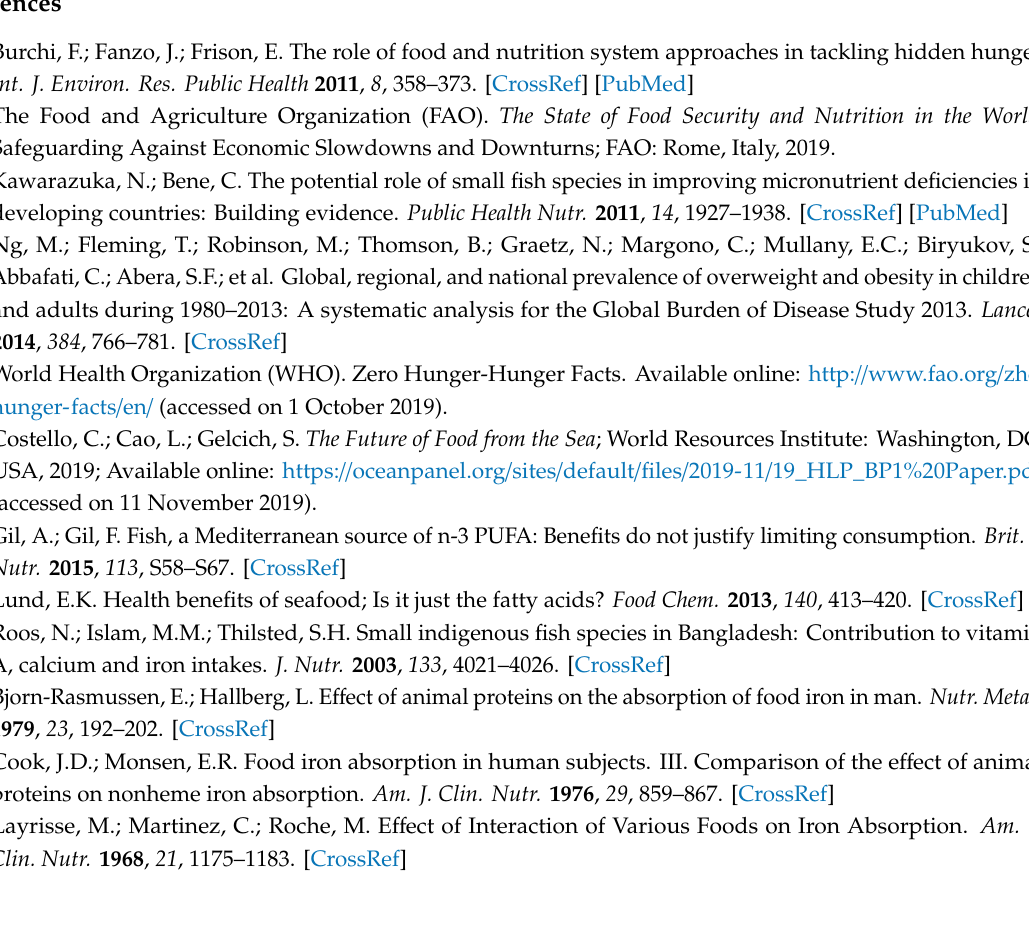
Figure S1: The mesopelagic fish species silvery lightfish ( Maurolicus muelleri , bottom) is similar to sprat ( Sprattus sprattus , top), a commonly consumed fish, both in appearance and nutrient composition. Both fish were caught in the same catch. Photo by Martin Wiech, Figure S2: Dietary potential of mesopelagic biomass. Several mesopelagic species as sandwich spread. Photo by Martin Wiech, Table S1: Potential amount of protein, fat and selected micronutrients in six mesopelagic species per km 3 of Oster- and Bjørnafjorden in Norway, Table S2: Potential amount of selected macrominerals (Ca, Na, K, Mg, P) and micronutrients in the protein (Fe, Zn, Se) and in oil fraction (vitamin A1) from six mesopelagic species of Oster- and Bjørnafjorden in Norway on wet weight basis, Table S3: Relative amounts of wax esters in B. glaciale and E. arcticus , Video S1: Sorting of trawl